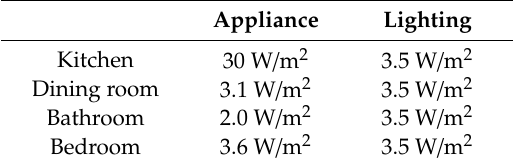
Table 1. Main data concerning the simulated building—thermal zones.